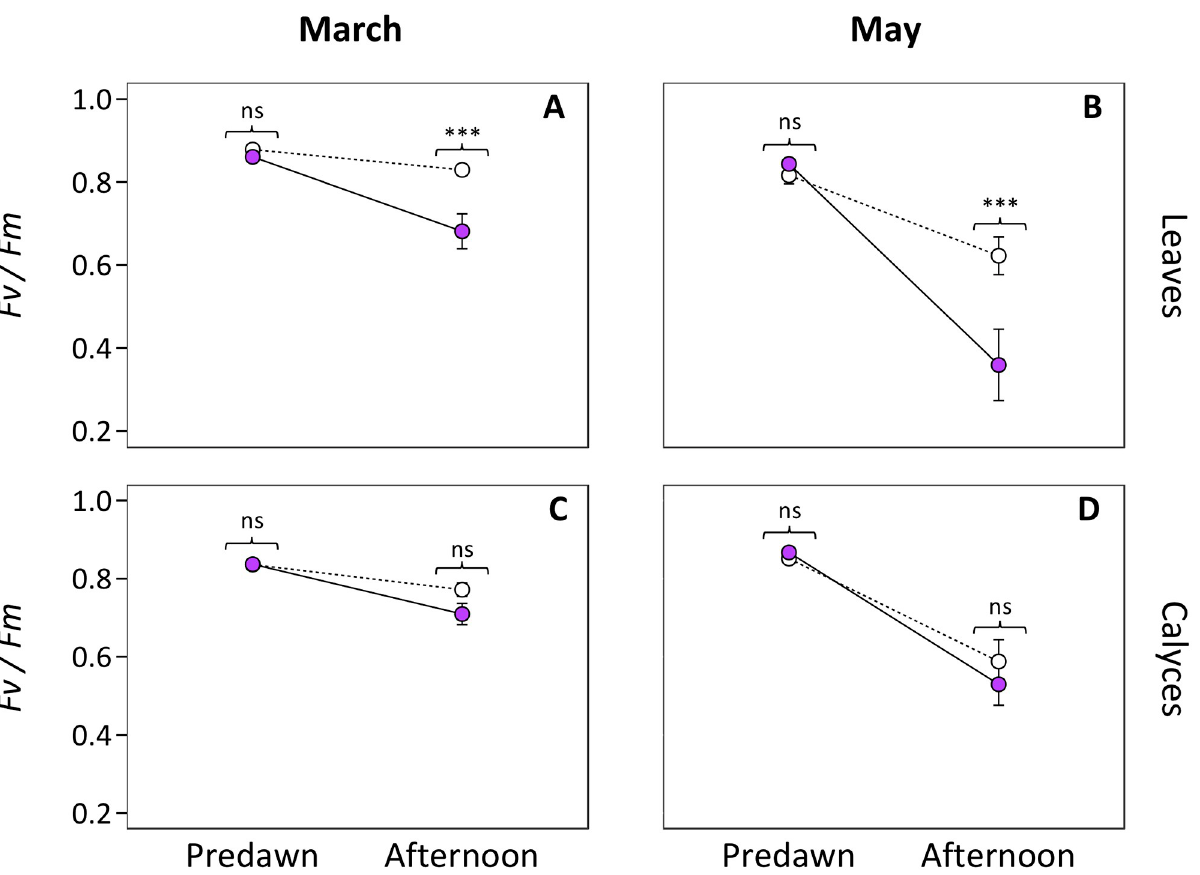
Fig 3. Variation of photochemical efficiency ( Fv / Fm ) from predawn conditions to afternoon. The mean Fv/Fm values from leaves (A, B) and calyces (C, D) in the early flowering (March; A and C) and peak flowering (May; B and D) periods are shown. Plants from the UV-present treatment are displayed by pink filled circles and solid lines, whereas those from the UV-exclusion treatment are displayed with empty circles and dashed lines. Statistical results of independent pairwise comparisons using Bonferroni adjustment between UV treatments in predawn and afternoon conditions are displayed. ns, not significant; ��� , P < 0.001. Error bars represent ±